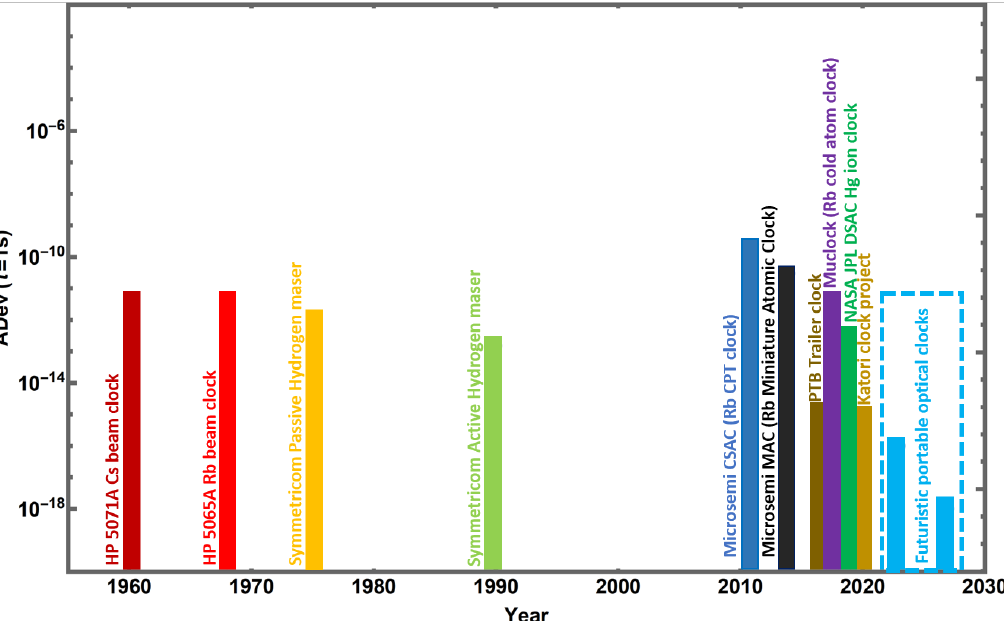
Figure 3. At a glance, Allan Deviations (ADevs) of the commercially available portable microwave and forthcoming optical atomic clocks indicate their performances. Colours were arbitrarily chosen only to distinguish the different types.